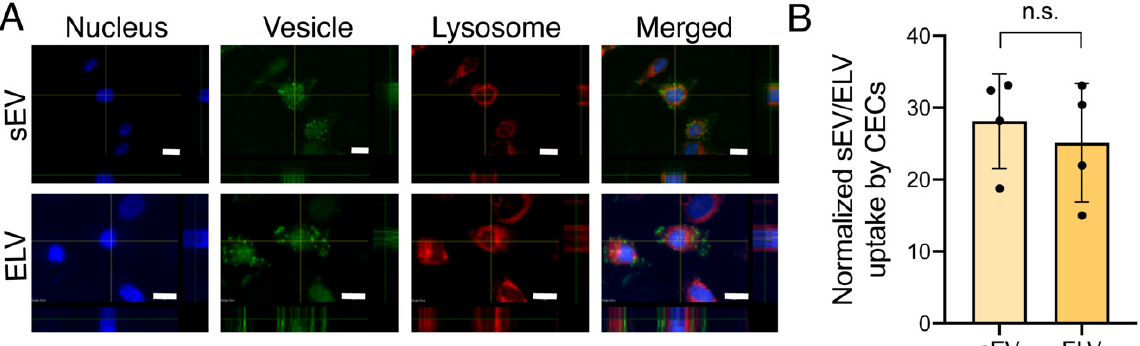
Figure 4. miR-126+ ELVs are successfully taken up by cardiac endothelial cells (CECs). ( A ) Representative images of calcein stained ELV and sEV (green) uptake by 2D CEC cultures labeled for nuclei (blue) and lysosome (red). Images were obtained by confocal laser scanning microscopy from central focal plane with orthogonal images on right and bottom. Scale bar = 10 µ m. ( B ) Quantification of uptake of calcein+ ELVs and sEVs by CECs through flow cytometry. Data normalized to negative control. n = 4 represent biological replicates. Mean ± SEM. Significance was tested with two-way Student’s paired t -test. n.s. = not